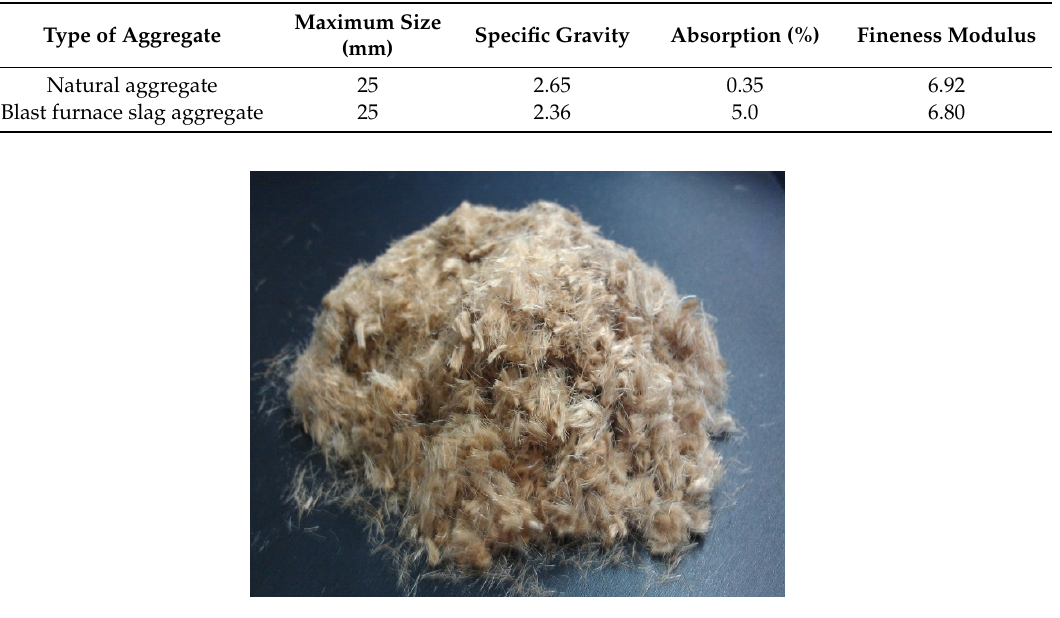
Table 3. Physical properties of coarse aggregate.